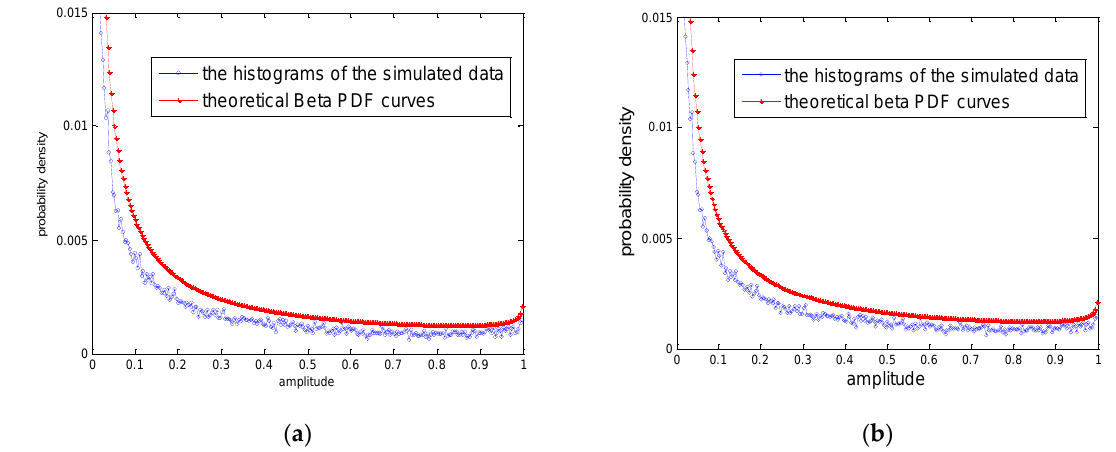
Figure 2. The histograms of the simulated data and the corresponding theoretical Beta probability density function (PDF) curves. ( a ) λ = 0.15 χ = 0.85; ( b ) λ = 1.15 χ = 1.85. Similar but di ff erent to the method of Conte, Wallace generated the Gamma RV with shape parameter v 2 by multiplying a Beta RV β ∼ Be ( β ; v 2 , 2 − v 2 ) and a Gamma distributed RV [16]. However, both of them have the deviation with general rejection method due to v 2 <